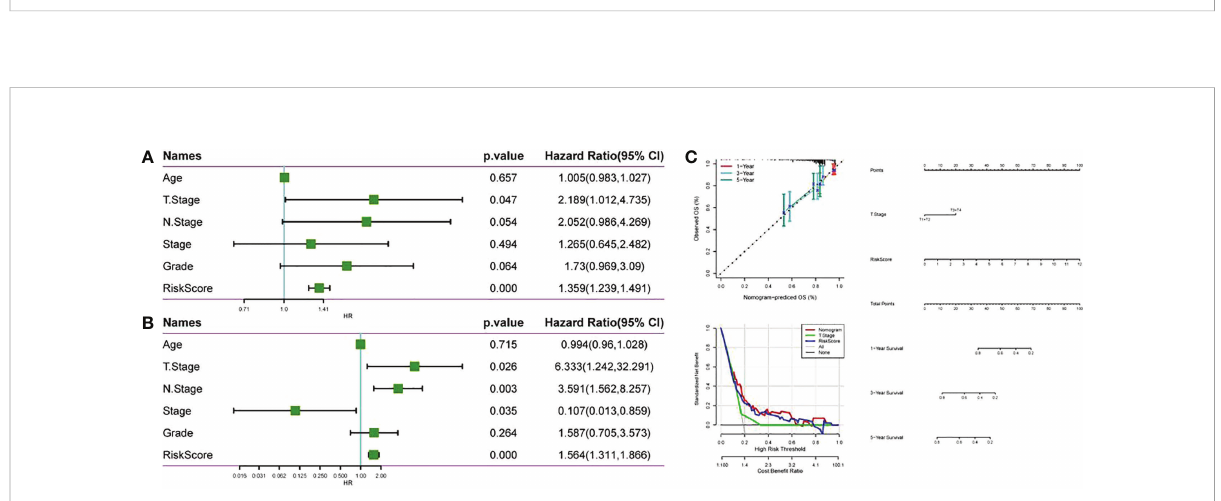
FIGURE 10 Compared with other clinicopathological features, RiskScore has higher prognostic value. (A) Forest map of clinical phenotype in the TCGA cohort and univariate Cox analysis of RiskScore; (B) Forest map of clinical phenotype in the TCGA cohort and multivariate Cox analysis of RiskScore; (C) Anomogram, nomogram alignment map and DCA curve constructed by TCGA data